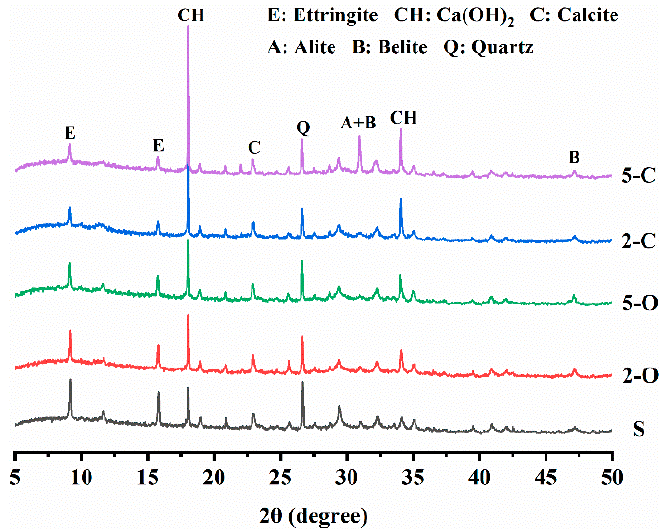
Figure 12. X-ray diffraction patterns of specimens under sulfate attack.